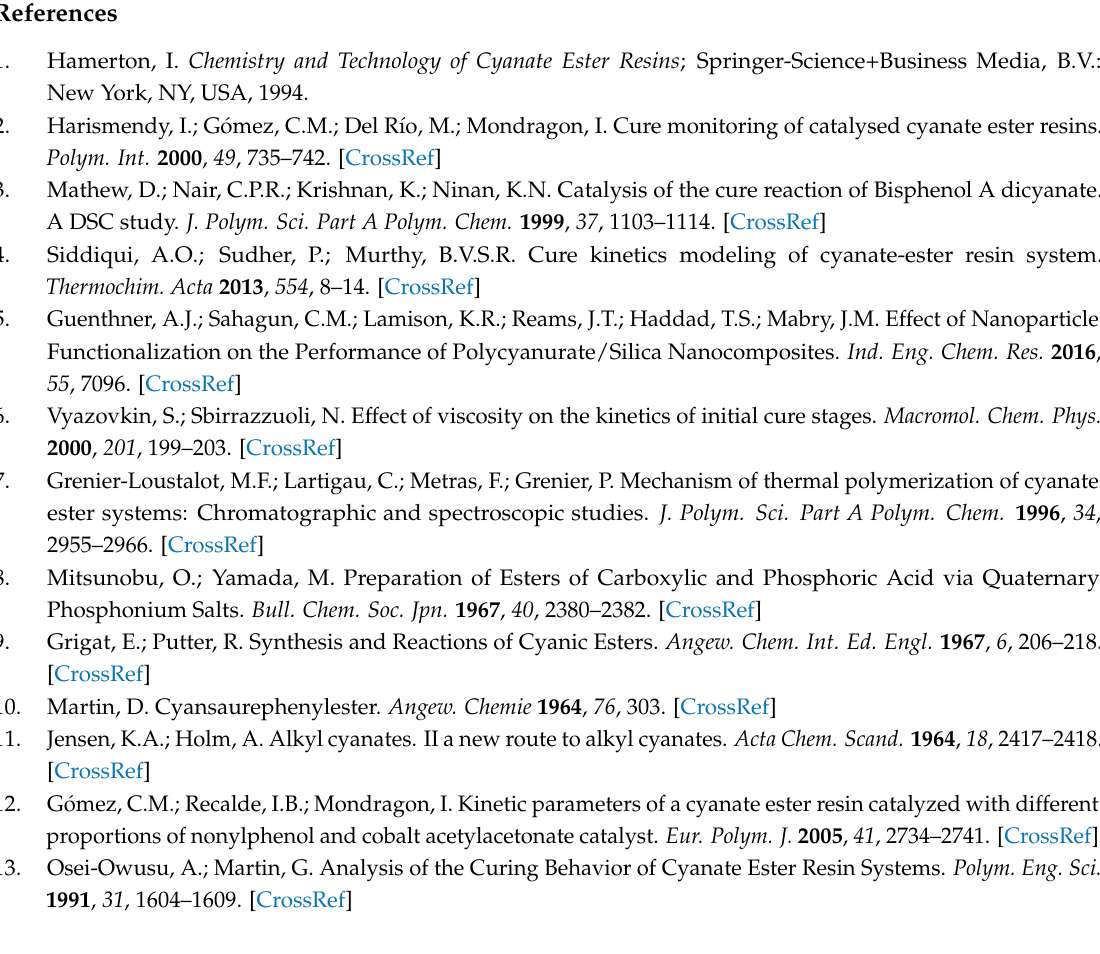
NMR 1H spectrum of 4-((4-methoxyphenyl)thio)phenol, Figure S2: NMR 13C spectrum of 4-((4-methoxyphenyl)thio)phenol, Figure S3: IR spectrum of 4-((4-methoxyphenyl)thio)phenol, Figure S4: EI mass spectrum of 4-((4-methoxyphenyl)thio)phenol, Figure S5: NMR 1H spectrum of 4-((4-methoxyphenyl)sulfonyl)phenol, Figure S6: NMR 13C spectrum of 4-((4-methoxyphenyl)sulfonyl)phenol, Figure S7: IR spectrum of 4-((4-methoxyphenyl)sulfonyl)phenol, Figure S8: EI mass spectrum of 4-((4-methoxyphenyl)sulfonyl)phenol, Figure S9: NMR 1H spectrum of (4-cyanatophenyl)(4-methoxyphenyl)sulfane, Figure S10: NMR 13C spectrum of (4-cyanatophenyl)(4-methoxyphenyl)sulfane, Figure S11: IR spectrum of (4-cyanatophenyl)(4-methoxyphenyl)sulfane, Figure S12: EI mass spectrum of (4-cyanatophenyl)(4-methoxyphenyl)sulfane, Figure S13: MALDI mass spectrum of (4-cyanatophenyl)(4-methoxyphenyl)sulfane cyclotrimerization